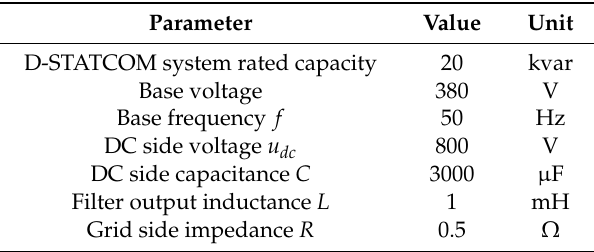
Table A1. D-STATCOM system parameters.